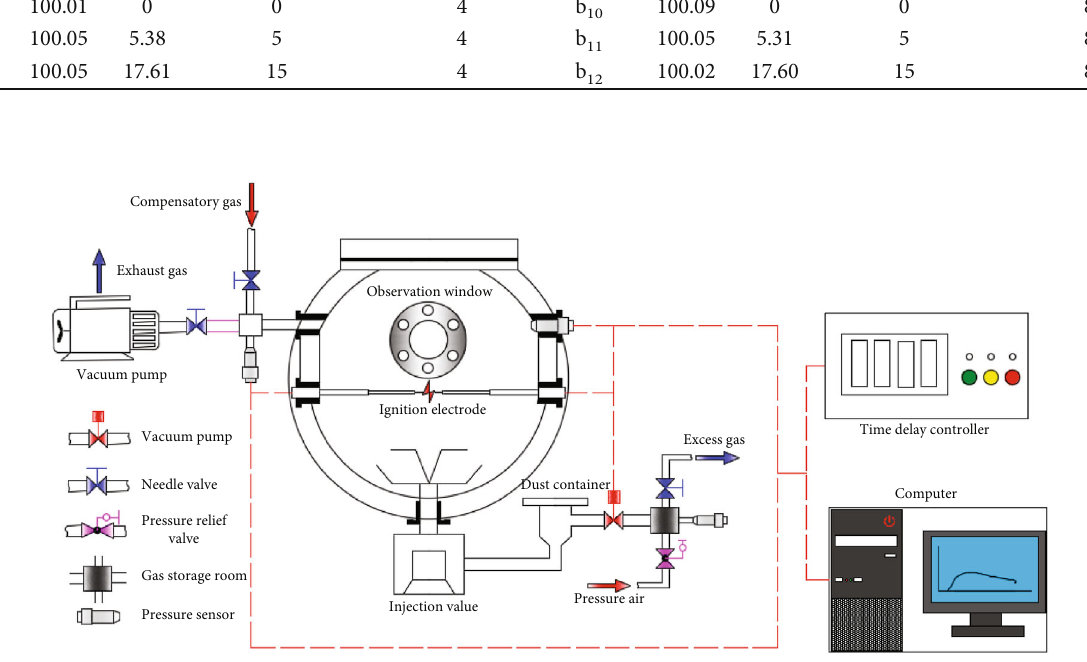
Figure 4: 20-liter spherical explosion test